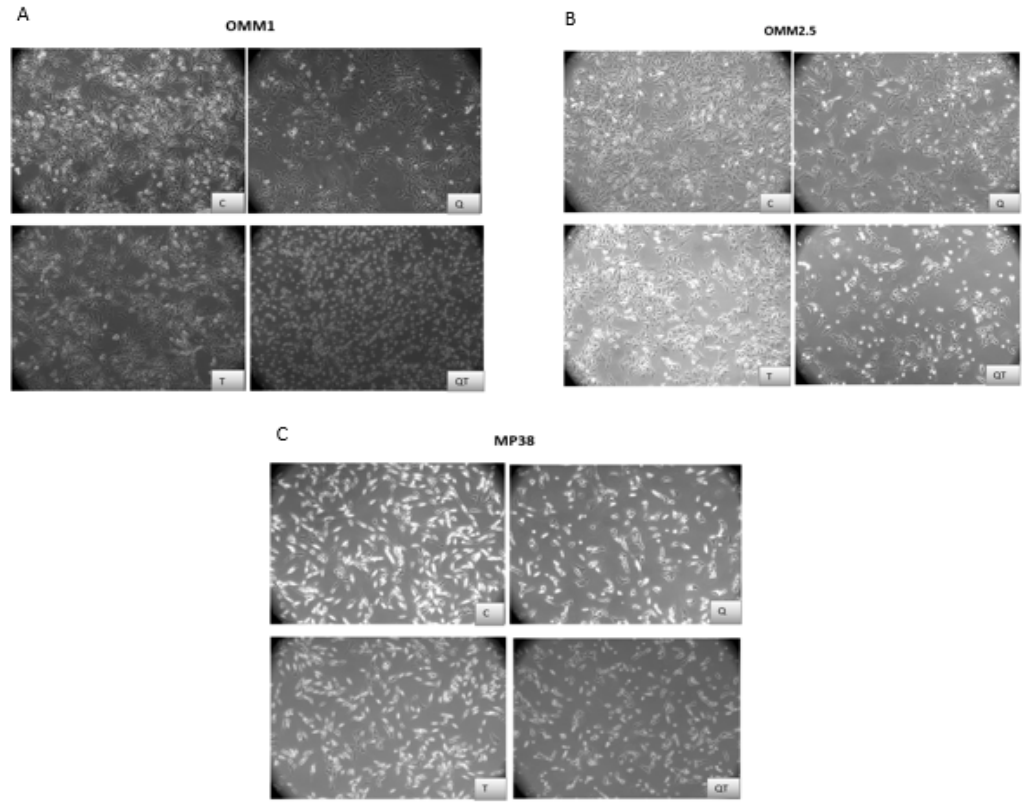
Figure 2. Photographs of uveal melanoma cell lines taken after 48 h exposure to Quisinostat (Q) and / or Tazemetostat (T): the photographs (magnification 100 × ) show fewer and more rounded cells after incubation with 40 nM Q and after combination treatment. ( A ) = cell line OMM1, ( B ) = cell line OMM2.5, ( C ) = cell line MP38. C: control; Q: 40 nM Quisinostat; T: 5 µM Tazemetostat; QT: combination of 40 nM Quisinostat and 5 µM Tazemetostat.